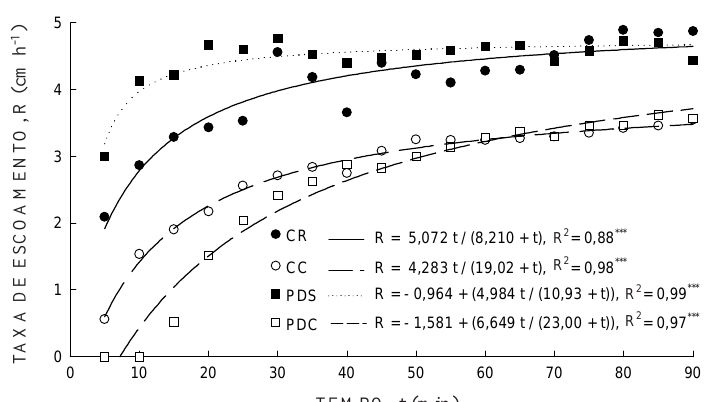
Figura 1. Taxa de escoamento (R) em função do tempo (t) de aplicação da chuva, em diferentes preparos e consolidação do solo (CR = convencional recente, CC = convencional consolidado, PDS = plantio direto sem palha, PDC = plantio direto com palha). *** = P